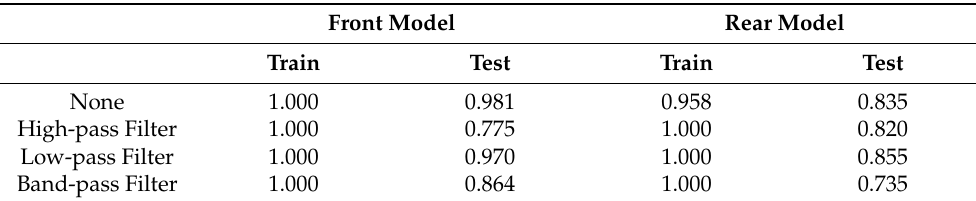
Table 3. Accuracy rate of the proposed